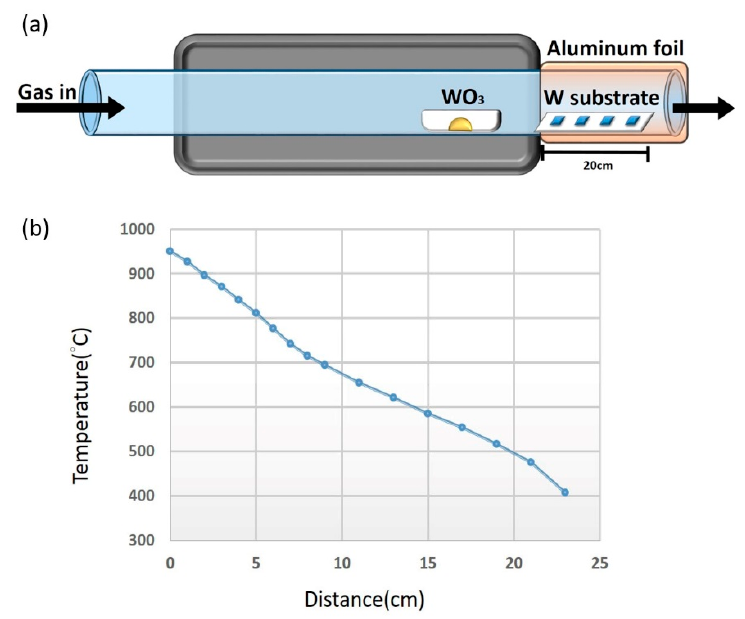
Figure 1. Experimental process. ( a ) Schematic illustration of thermal evaporation technique to syn- thesize WO 3 NWs. ( b ) Temperature versus substrate position diagram measured with a thermal couple.